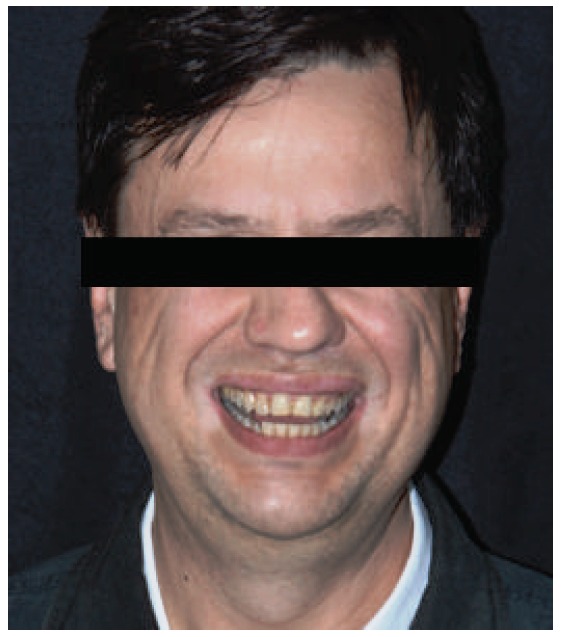
Face photograph.